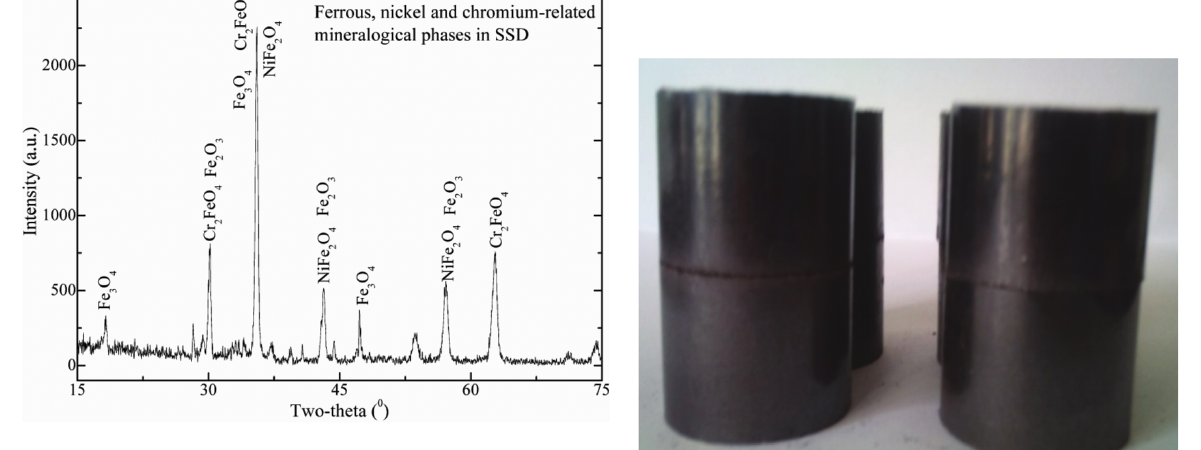
Figure 4: Stainless steel dust morphology by SEM tests.